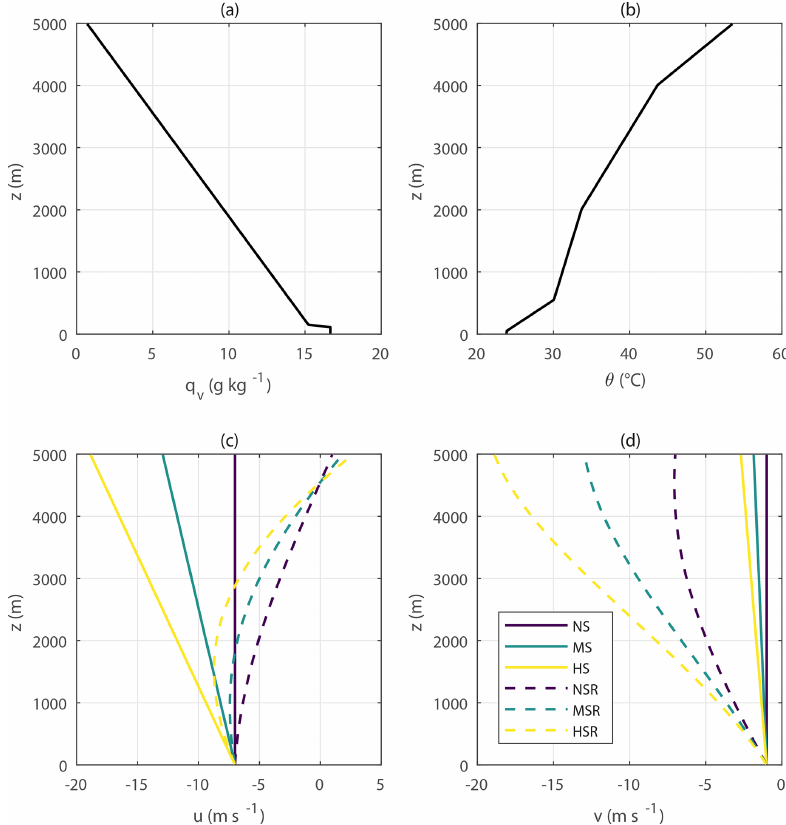
Figure 2. Input profiles of (a) water-vapour-specific humidity q v , (b) potential temperature θ , (c) zonal wind component u , and (d) meridional wind component v . The large-scale wind forcing is the same as the initial conditions of the respective runs, remaining unchanged throughout the whole simulations. The initial profiles of both q v and θ are the same for every run, the only difference being the vertical wind variability. Three levels of wind speed shear are defined: no wind speed shear (NS), moderate wind speed shear (MS), and high wind speed shear (HS). A clockwise rotation of 90 ◦ in wind direction between 0 and 5km is applied in the NSR, MSR, and HSR runs, which have the same wind speed shear as NS, MS, and HS,